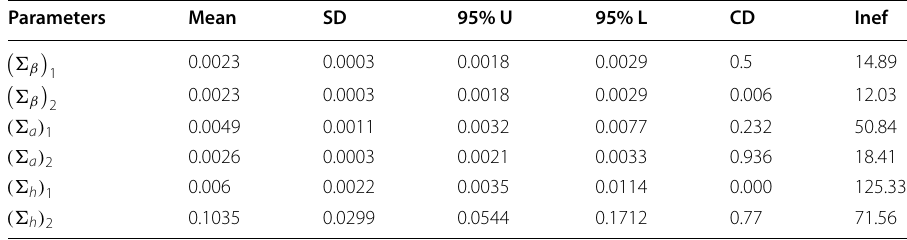
Table 3 Estimation results of the TVP-VAR-SV parameters with the ordering { EPU , R , NEF } Parameters Mean SD 95% U